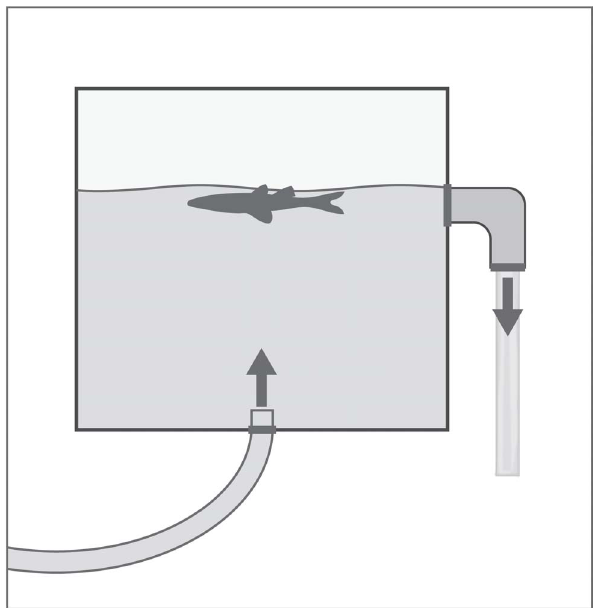
Figure 1. Chambers designed to assess the degradation of DNA from a silver carp carcass. Arrows indicate the direction of water flow. (20 m L) contained 8 m L of template DNA, 1 m M forward and